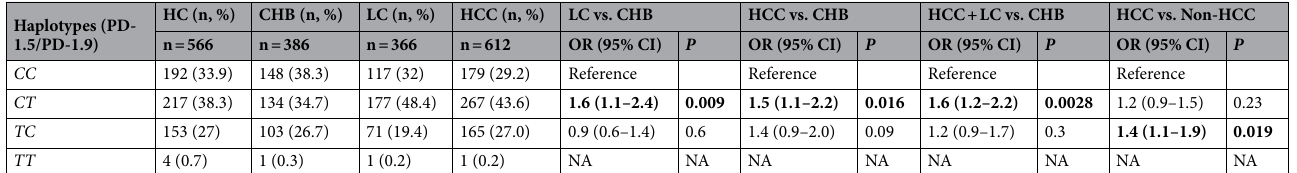
Table 4. Association of PD1 haplotypes with HBV-related liver diseases. ORs and P- values were calculated by using binary logistic regression model adjusted for age and gender. Bold values present the statistical significance. CHB chronic hepatitis B, LC liver cirrhosis, HCC hepatocellular carcinoma, HC healthy control, non-HCC CHB + LC, n number of chromosomes, NA not applicable, OR adjusted odds ratio.